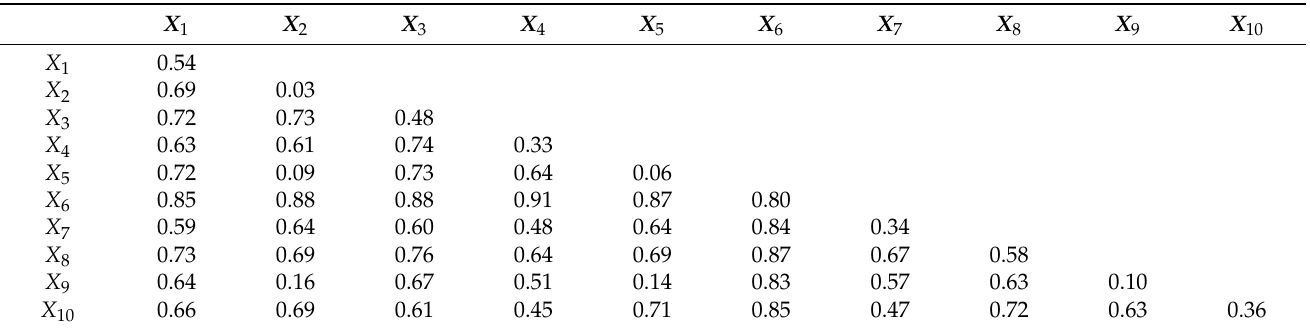
Table 4. Factor interaction analysis of the